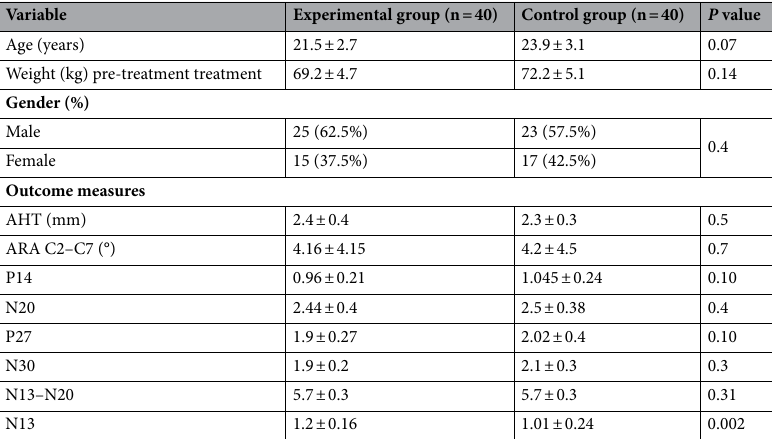
Table 1. Descriptive data for the demographic and clinical variables are presented. No statistically significant differences between the control group and the experimental group were found at baseline for their demographic and clinical variables, except for N13 ( P = 0.0022). The values are presented as mean and standard deviation (SD) for age, weight, anterior head translation (AHT), absolute rotation angle (ARA C2–C7 lordosis), and neurophysiological